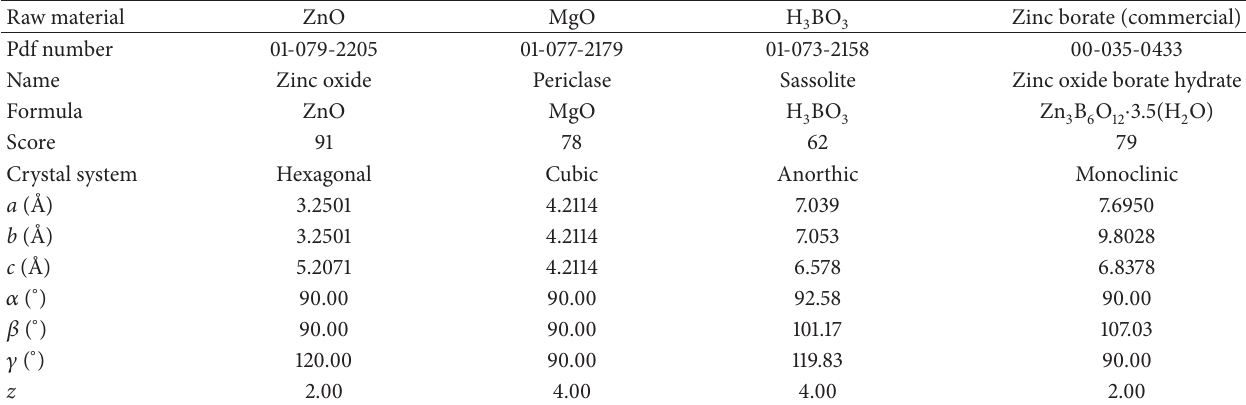
Table 1: XRD results and crystallographic data of the raw